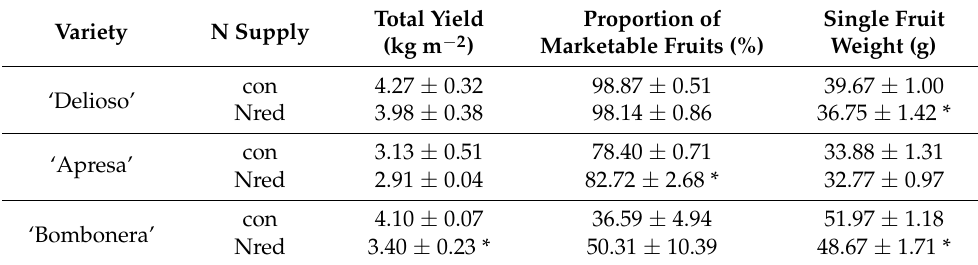
Table 2. Total yield, proportion of marketable fruits and weight of single fruits in three tomato varieties with normal (con) and reduced (Nred) N supplies. N = 4 ± SD. Asterisks in the “Nred” line indicate significant differences between the “con” and the “Nred” treatment for the respective tomato varieties ( t -test at α = 0.05). Total Yield Proportion of Single Variety N Supply (kg m − 2 ) Marketable Fruits (%)